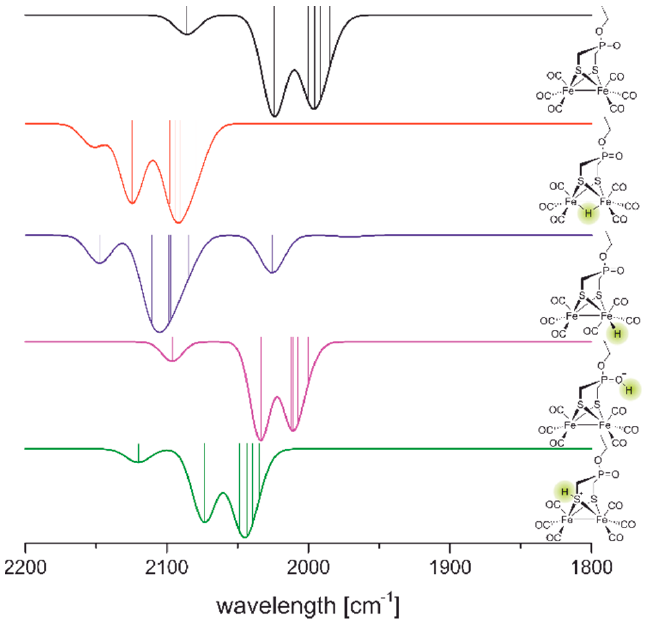
Figure 9. DFT derived IR spectra of 12-OEt in its neutral and protonated form. Protonation sites are highlighted in green for better readability.